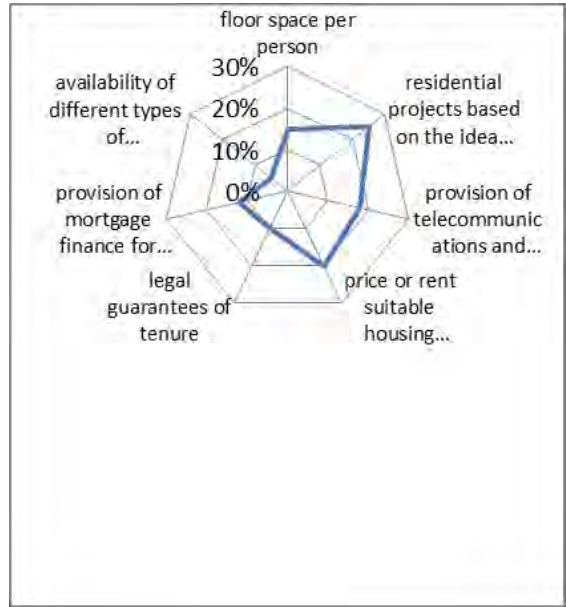
Figure 3. Availability of affordable housing and the provision of facilities